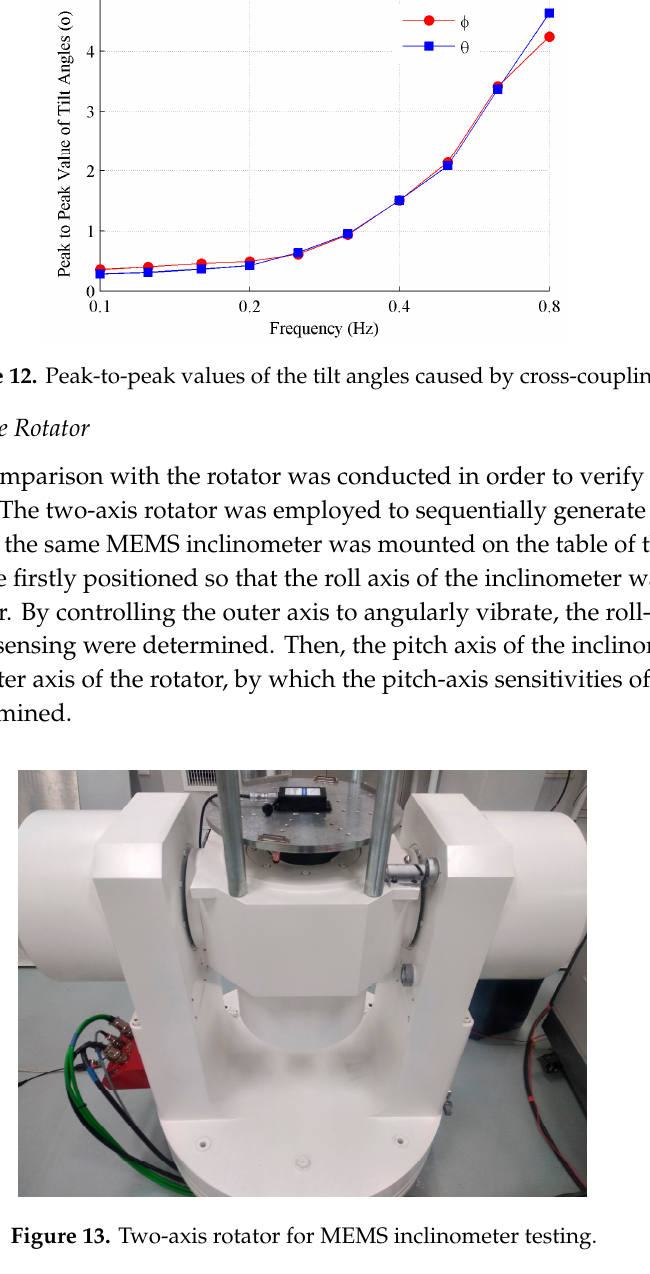
Figure 11. Tilt angles vary with time, caused by cross-coupling.